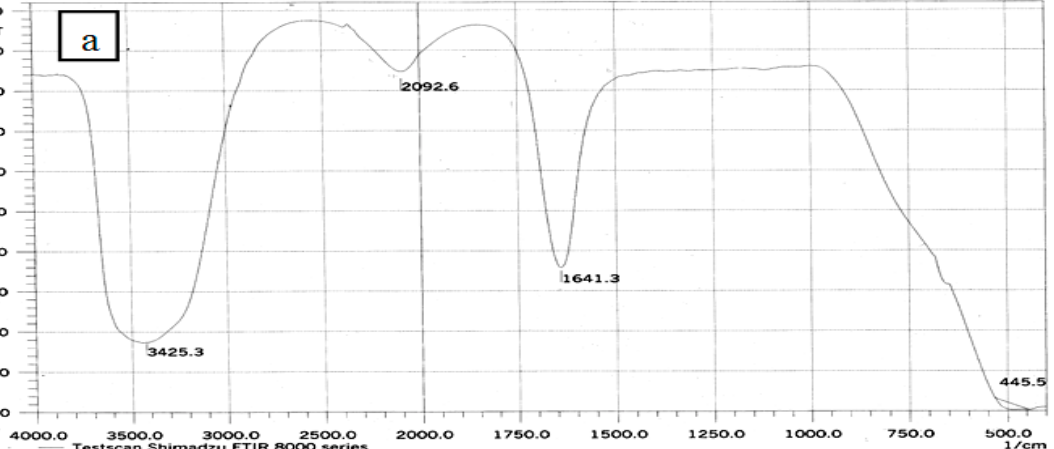
Figure 4. FTIR spectra of TiO 2 NPs synthesized: ( a ) 80 mJ; ( b ) 200 mJ. Figure 5 exhibits an XRD patterns of TiO 2 NPs synthesized in in deionized distilled water by laser irradiation (200 mJ pulse − 1 : 10 min). A pattern shows intensity at 2 θ = 35.4° (101) and 38.8° (112) corresponding to the crystal formation of rutile and anatase TiO 2 (JCPDS: 21-1276 and JCPDS: 21-1272) phase, respectively [18]. Moreover, an additional peak centered at 2 θ = 45° corresponding to ( − 403) plane phase assigned to the β -TiO 2 phase (JCPDS No. 46-1238). A grain size value (D) was determined using Scherrer’s formula (aforementioned in the characterization section) are summarized in Table 1.